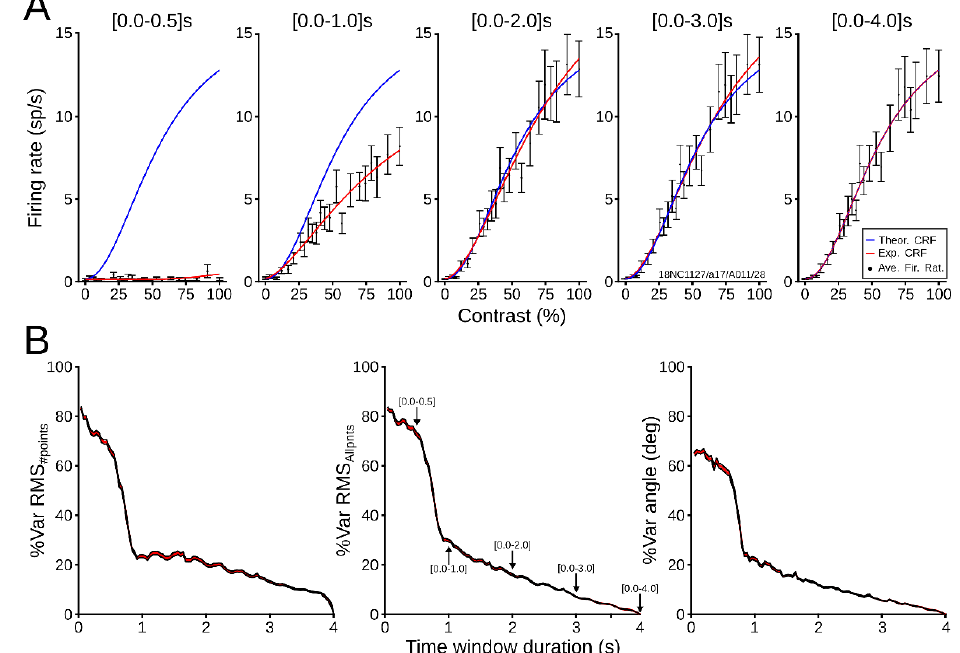
Figure 9. Dynamic response of CRFs. ( A ) Example of CRF fit to increasing lengths of recording time (red line). Average firing rates (black dots) are drawn with SEM (error bars). The theoretical curve is also depicted (blue line). ( B ) Average percentage of variation of RMS #points , RMS Allpnts, and angle difference between vectors as a function of increasing trail duration. Average (red line) and confidence interval of the mean (black lines) were obtained by bootstrapping the data (1000 iterations).